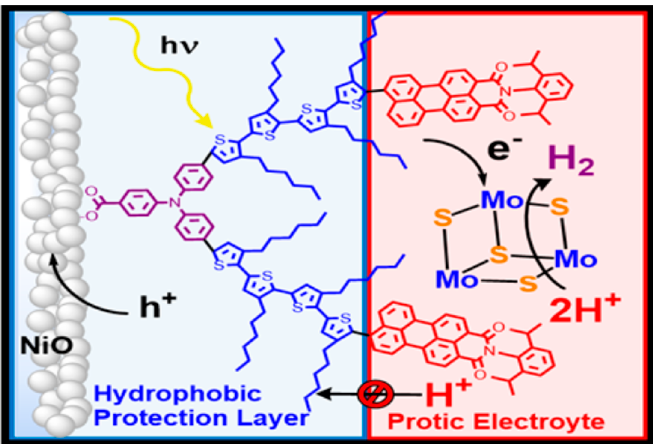
Figure 12. Scheme of photoactivated ET from NiO to H + mediated by the dye-sensitizer PMI-4T-TPA. The organic dye immobilized onto NiO surface is the dye-sensitizer which acts as electron donor towards the molecular co-catalyst Mo 3 S 4 , and as an electron acceptor from NiO. The picture evidences the blocking effect exerted by the hexyl groups against direct H + discharge onto bare NiO cathode (corresponding to a dark shunt effect). Reproduced with permission from reference [75].